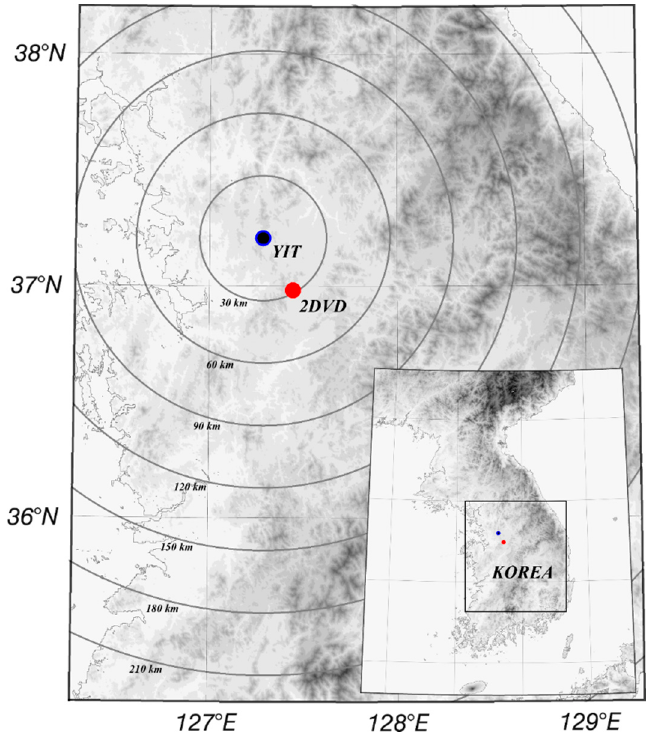
Figure 1. Locations of 2DVD (red bullet) and YIT dual-pol weather radar (blue bullet) deployed in South Korea.